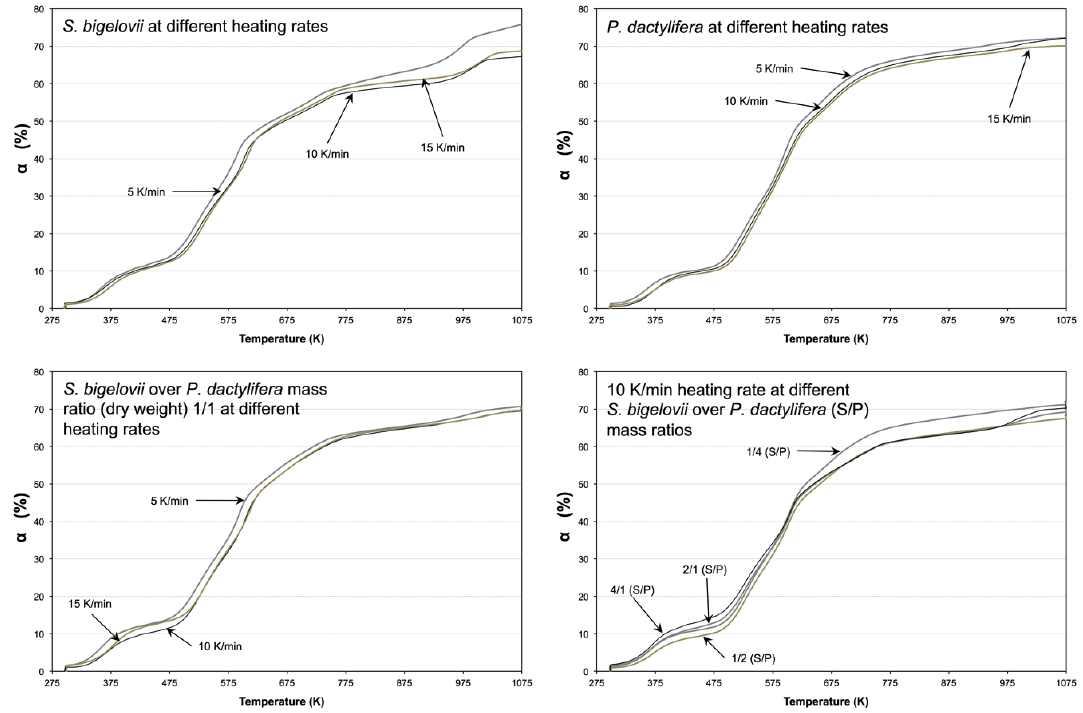
Figure 1. Comparison of the mass loss ( α ) curves of S. bigelovii , P. dactylifera , and mixtures of them, at different heating rates (K/min).